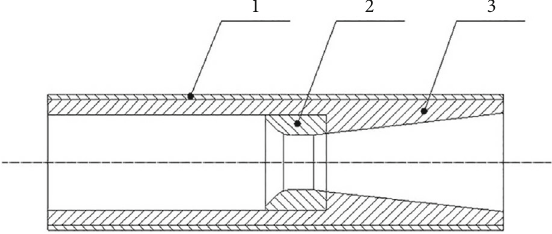
Figure 3: Schematic of the tail-pipe nozzle. 1: shell; 2: throat lining; 3: insulation